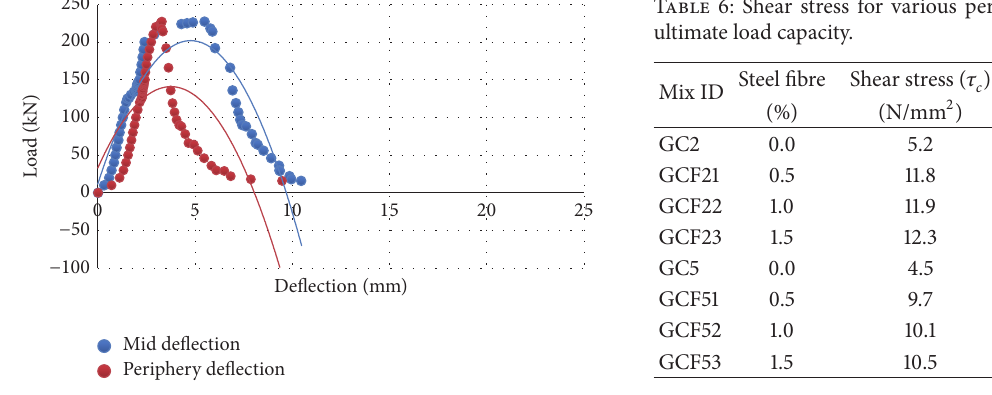
Figure 8: Punching shear values for 1.0% of steel fibre (GCF22).